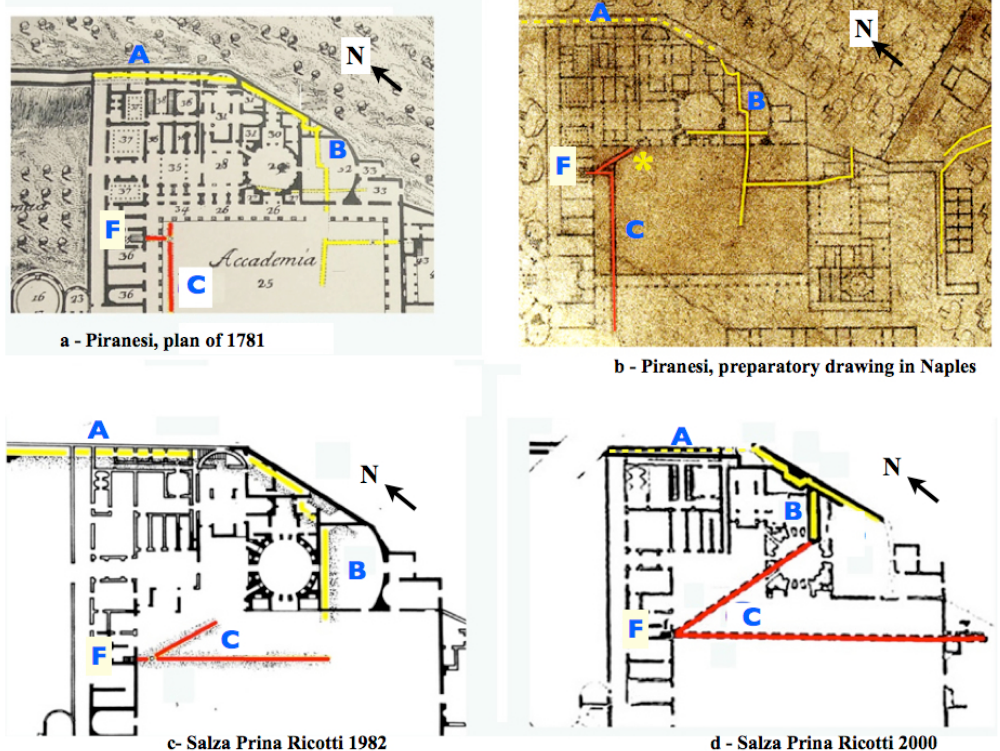
Fig. 4. Comparing ancient and modern plans of the tunnels C under the main porch. (a) plan by Piranesi 1781; (b) preparatory drawing of